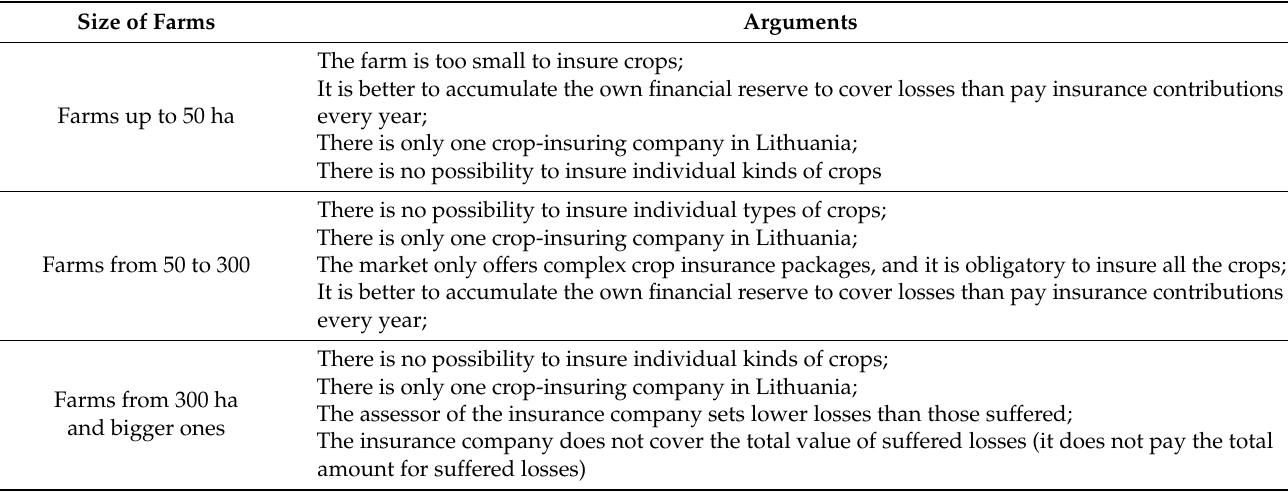
Table 5. Reasons that do not encourage farms to insure